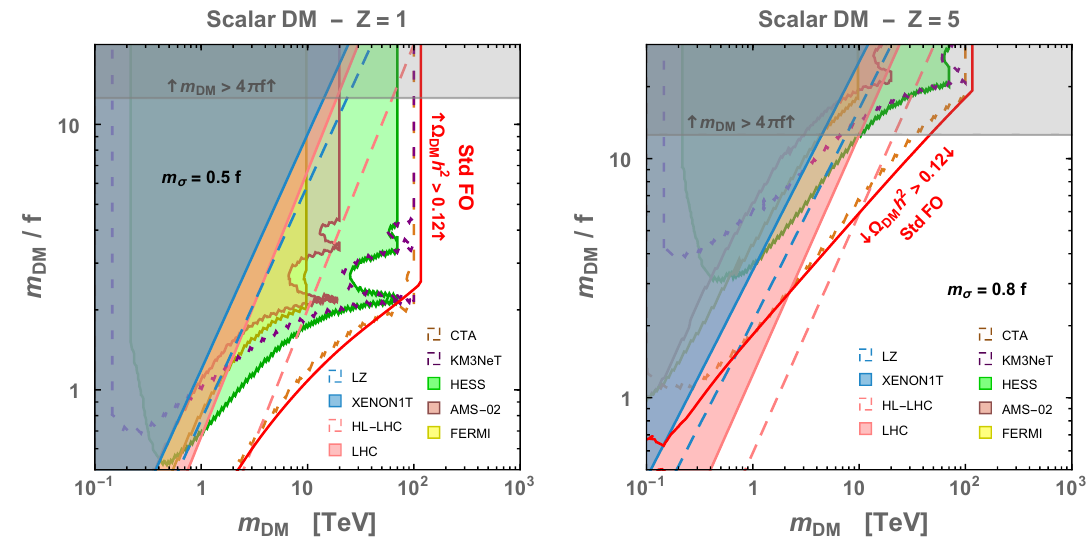
Figure 3 . Dilaton-mediated scalar DM in the standard freeze-out case . On the left (right) we set the dilaton normalization strength to Z = 1 ( Z = 5 ), cf. section 2.1, and the dilaton mass to m σ = 0 . 5 f ( m σ = 0 . 8 f ) to avoid significant supercooling, see figure 2. The red lines show the points leading to the correct DM abundance assuming the standard freeze-out paradigm, cf. section